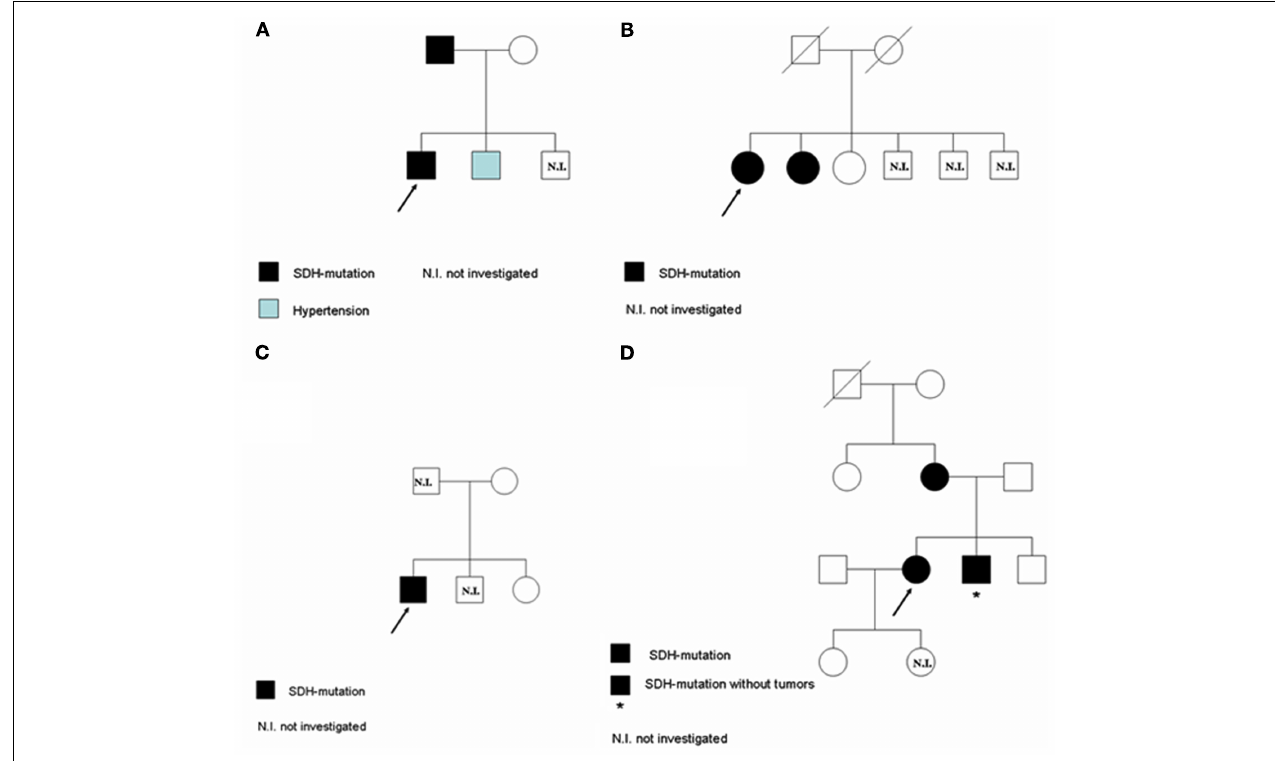
FIGURE 2 | Pedigree of the four families under investigation: family (A) corresponds to Patient 1; family (B) corresponds to Patient 2; family (C) corresponds to Patient 3; family (D) corresponds to Patient 4.